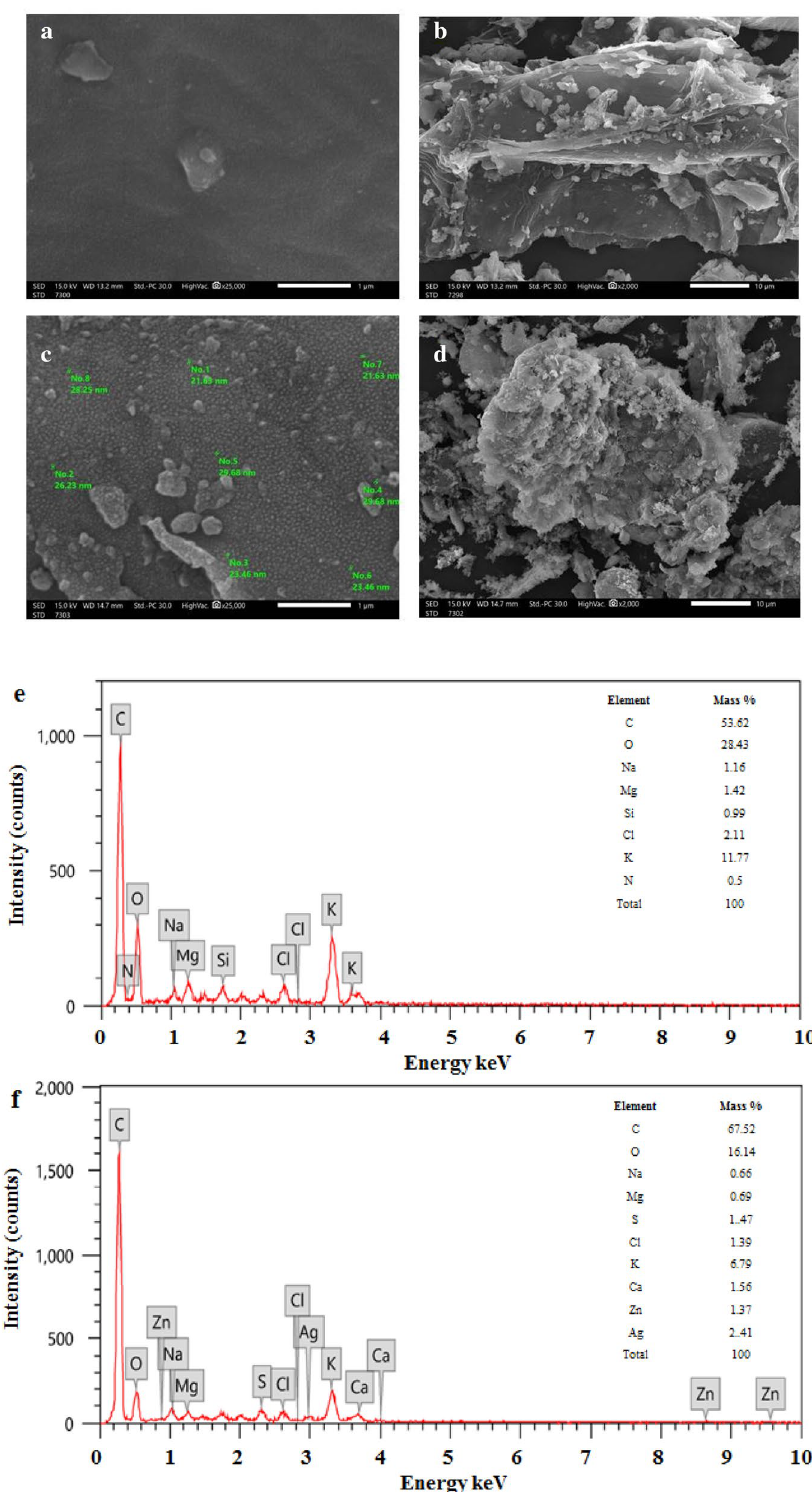
Figure 5. SEM images of biochar ( a ) and ( b ), Ag/ZnO@BC ( c ) and ( d ), EDX spectrum of pristine biochar ( e ), and Ag/ZnO@BC ( f